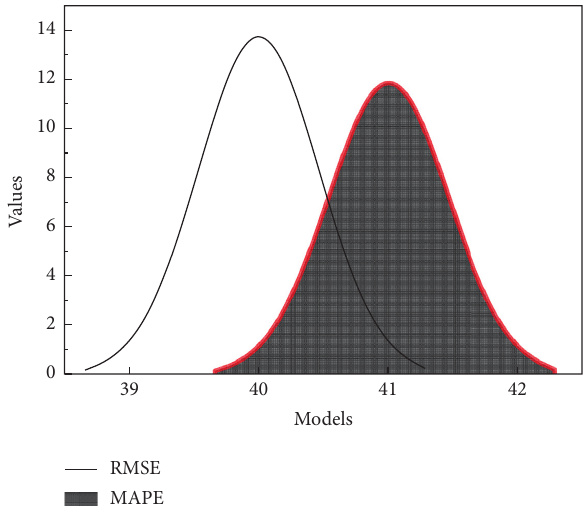
Figure 8: Evaluation indexes of the prediction results of each model.